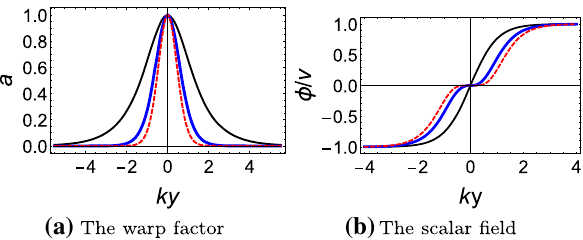
Fig. 1 Shapesofthewarpfactor a ( y ) andthescalarfield φ( y ) inmodel 1. The parameters are set as n = 1 for the black lines, n = 3 for the thick blue lines, and n = 5 for the dashed red